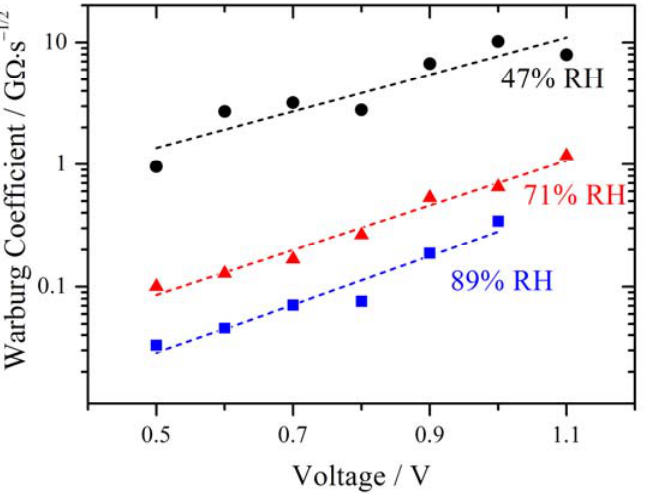
Figure 10. Simulated Warburg coefficients W plotted against the voltage for different relative humidities. With increasing RH the diffusion limitation decreases. An exponential increase with overpotential is observed as indicated by the fits (dashed